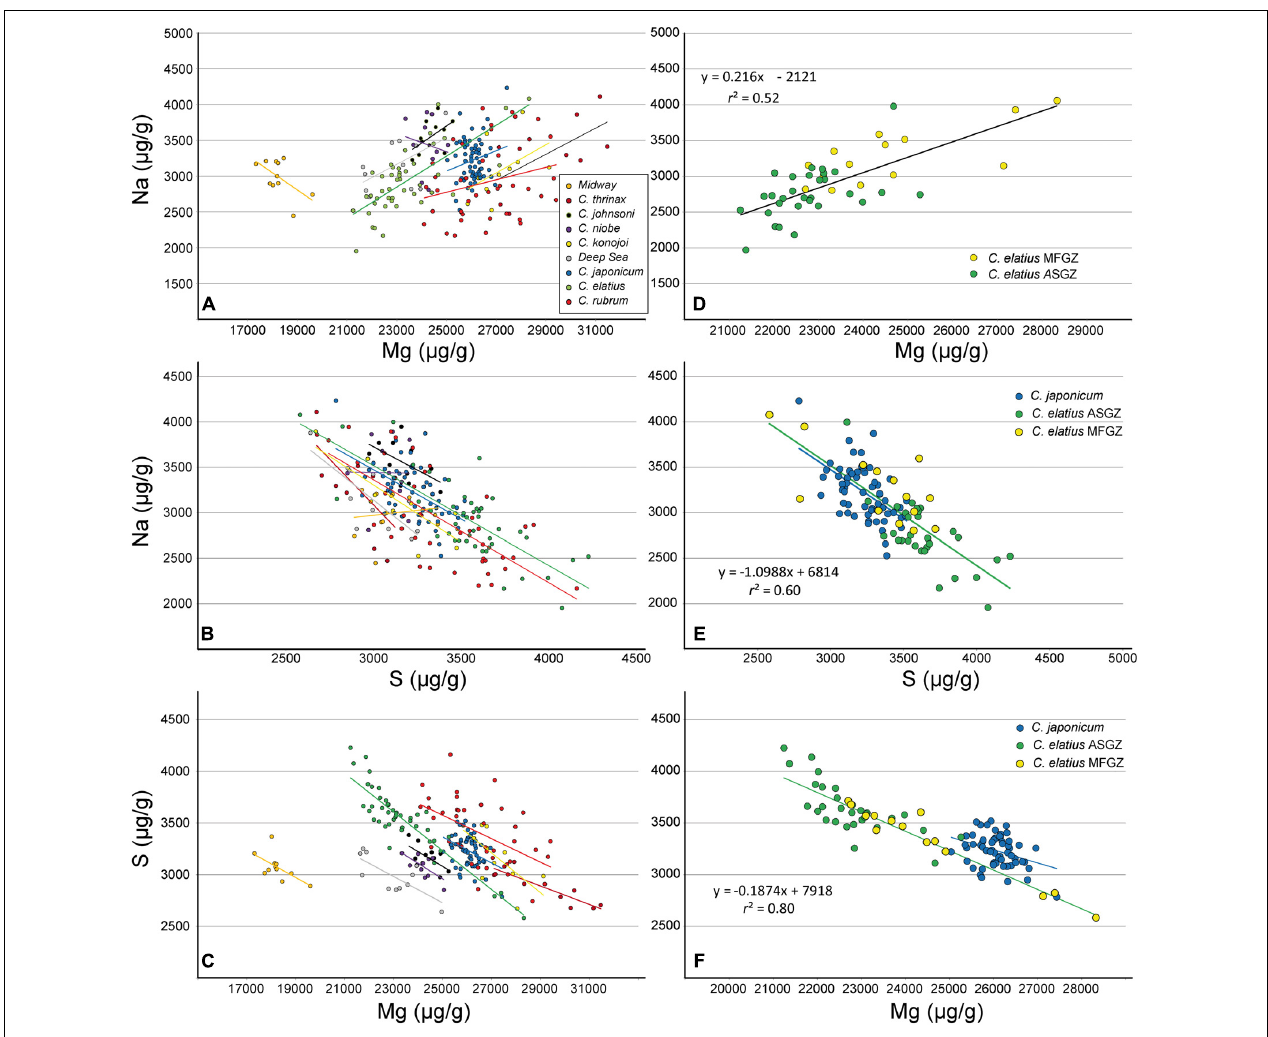
FIGURE 2 | Electron microprobe analyses of different Corallium skeletons [ Midway ( C. sp.), C. thrinax, C. johnsoni, C. niobe, C. konojoi, Deep sea ( C. sp.), C. japonicum, C. elatius, C. rubrum ]. (A–C) All data and linear adjustment for each species (equation parameters and correlation coefficients are supplied